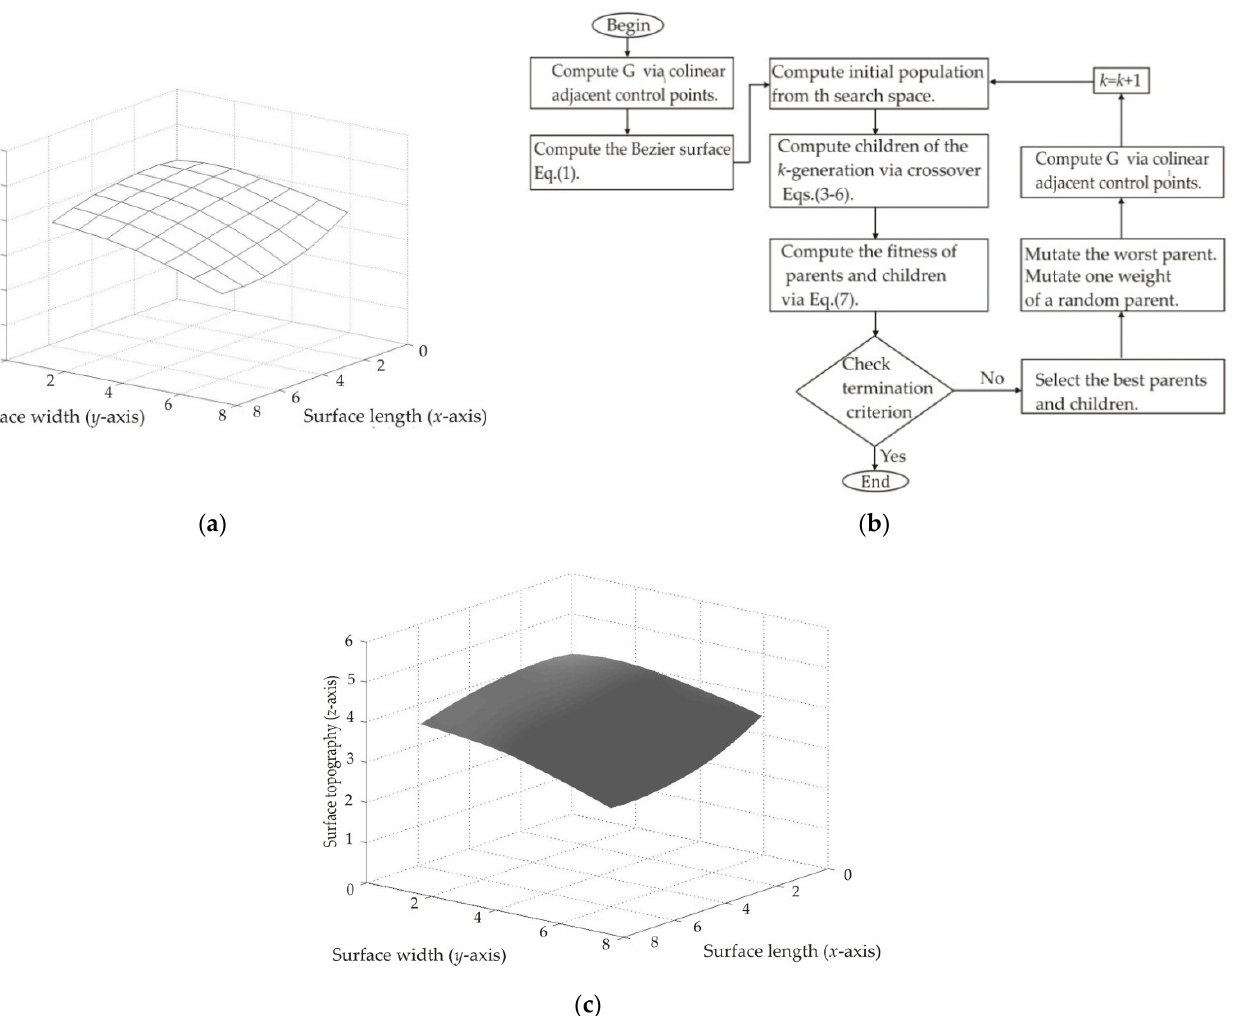
Figure 2. ( a ) Contour data to construct free-form surface model. ( b ) Flowchart to perform multi-objective optimization through a genetic algorithm. ( c ) Surface generated by the free-form surface model Equation (1). Table 1. Control points generated in the first and second